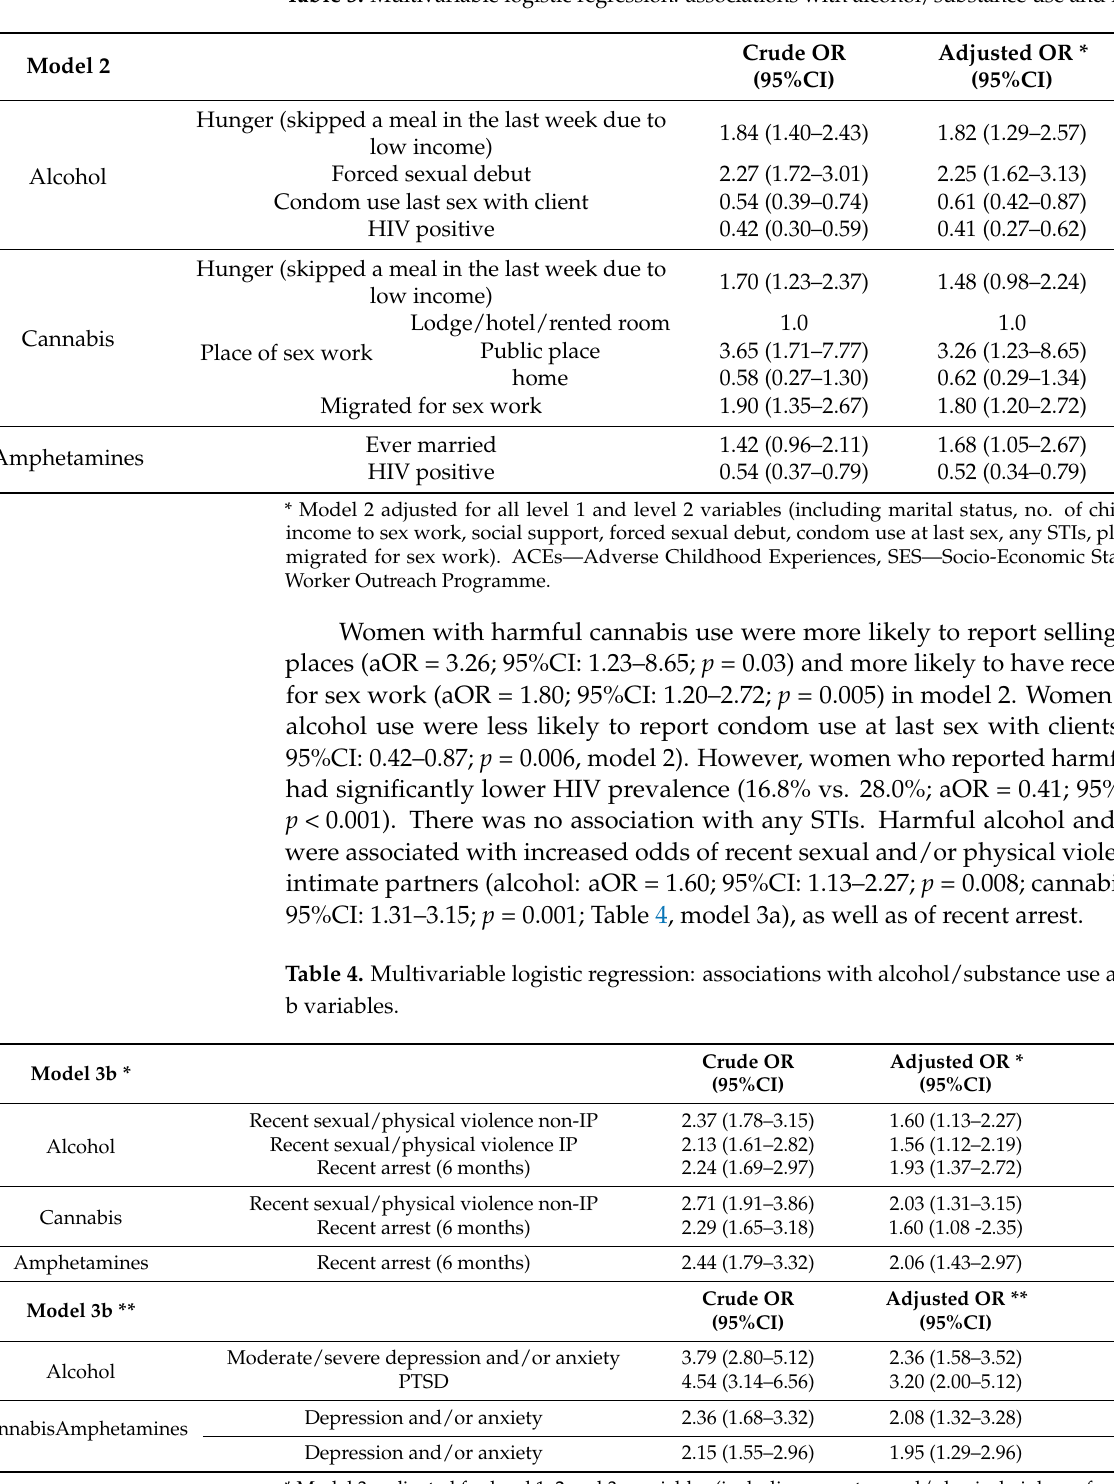
Table 3. Multivariable logistic regression: associations with alcohol/substance use and level 2 variables.